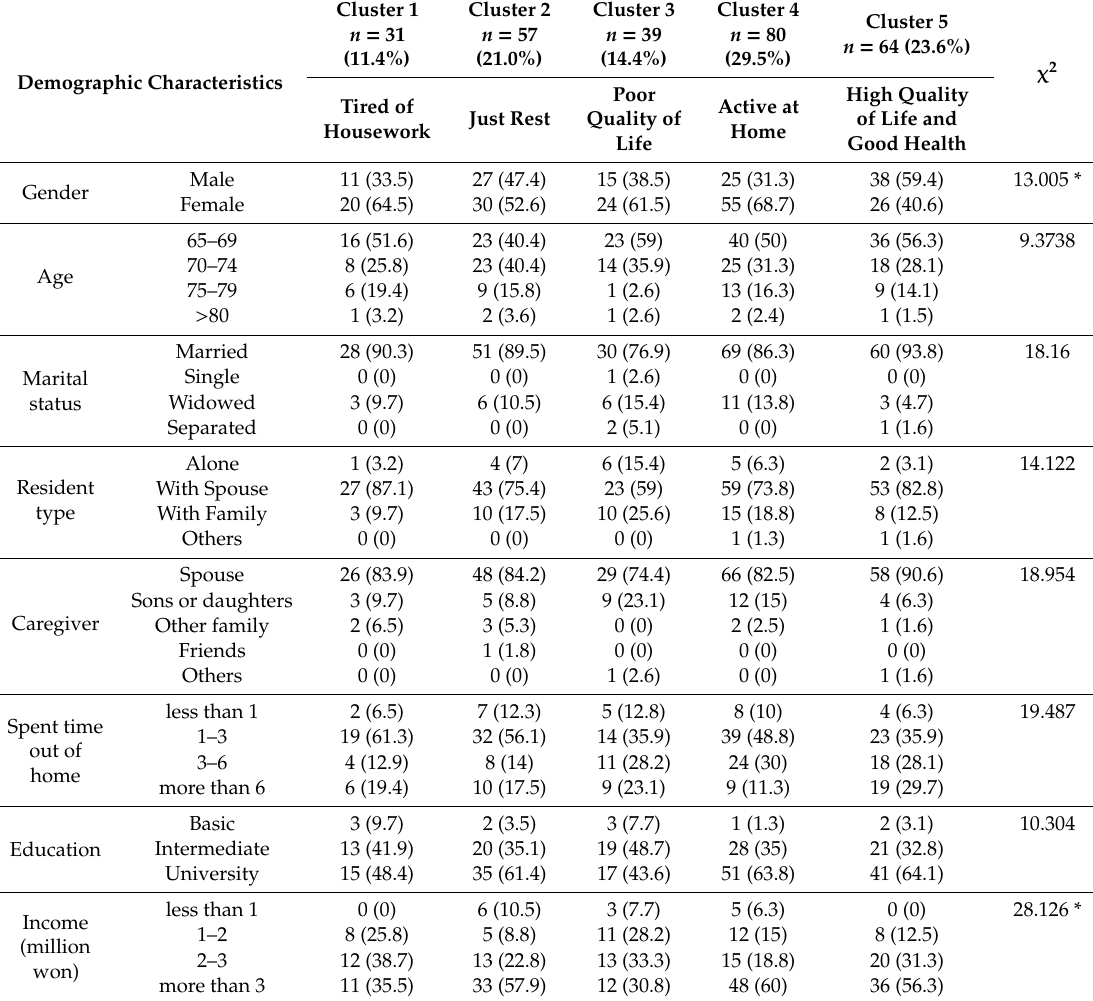
Table 3. Demographic characteristics of each